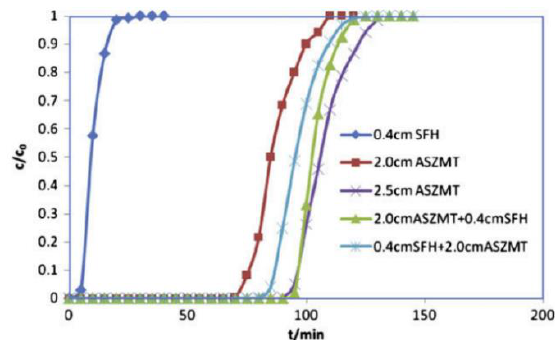
Figure 5. HCN penetration curves determined for microfiber-coated composites prepared by imple- menting different filling methods and ASZM–T granular carbon composite fixed beds. The initial concentration of HCN was 4 mg·L −1 , and the gas flow rate was 0.79 L·min −1 [64].